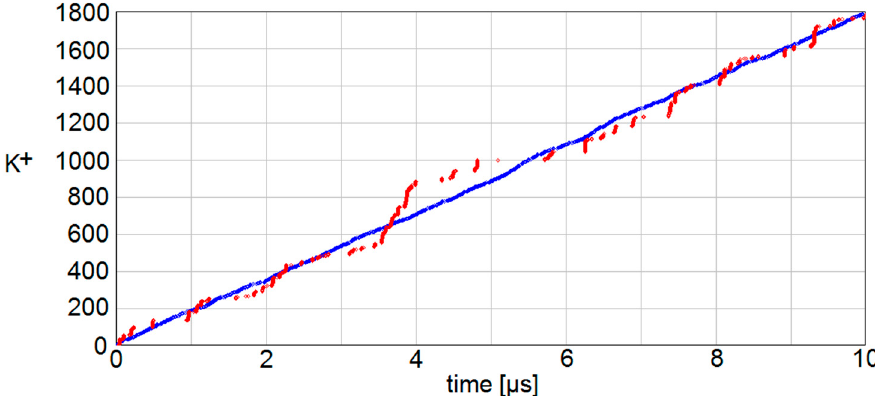
Figure 2. Red dots: Classical MD simulation of K + current through the SF during 10 µs; 1763 K+ ions left the SF at the extracellular side, mostly in bursts with very short time between successive ions. Blue dots: A mathematical sequence of random events according to a Poisson statistic which was set to produce a mean of 1763 events in 10 µs.